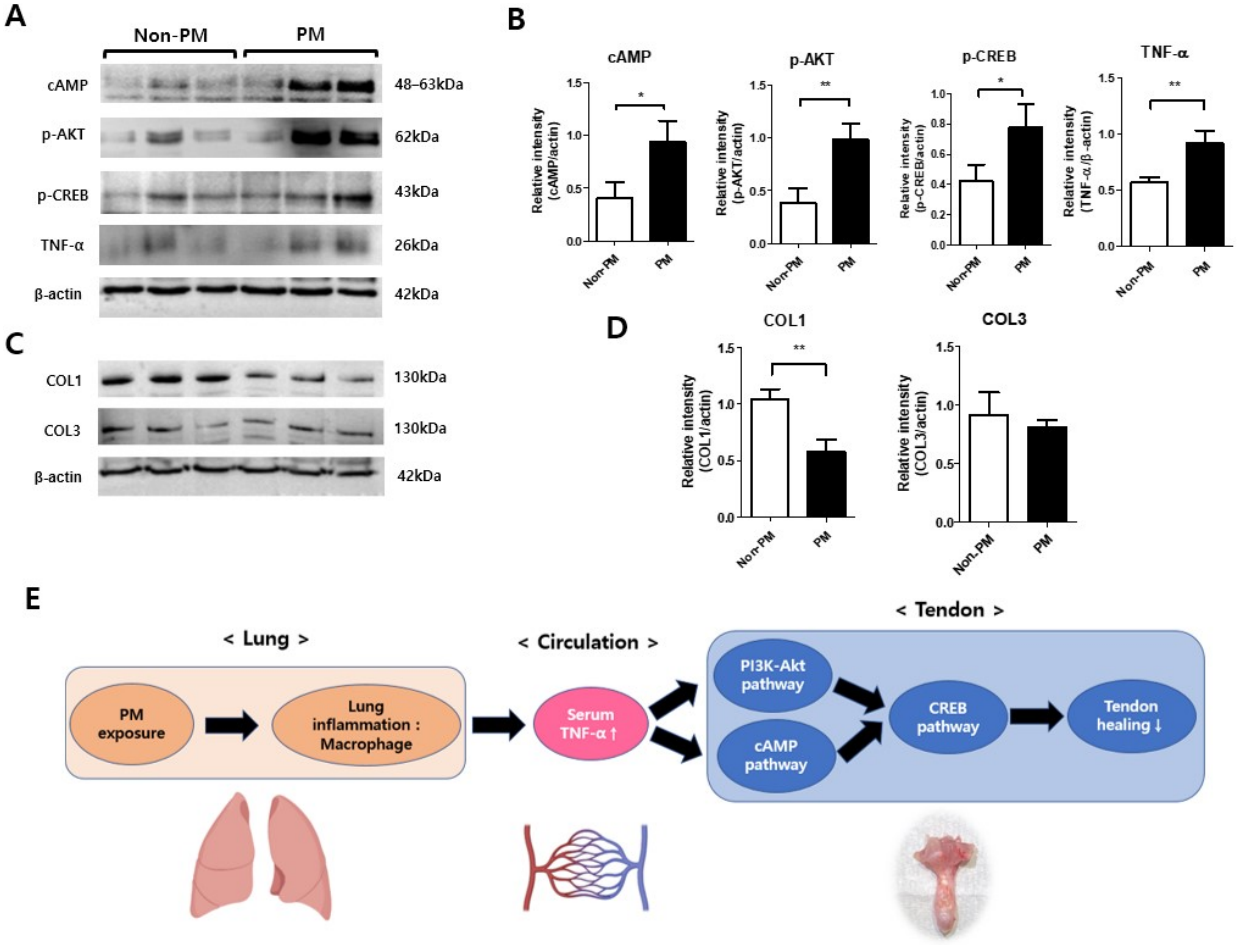
Figure 6. ( A ) Representative blots and ( B ) relative band intensities of cyclic adenosine monophosphate (cAMP), phosphorylated protein kinase B (p-Akt), phosphorylated cAMP response element-binding protein (p-CREB), and tumor necrosis factor-alpha (TNF- α ). ( C ) Representative blots and ( D ) relative band intensities of collagen type I (COL1) and COL3 in the control (non-PM) and PM-exposed rats. The relative band intensity was normalized to β -actin. * p < 0.05, ** p < 0.01. ( E ) Proposed schematic diagram showing the action mechanism of PM exposure on tendon healing.